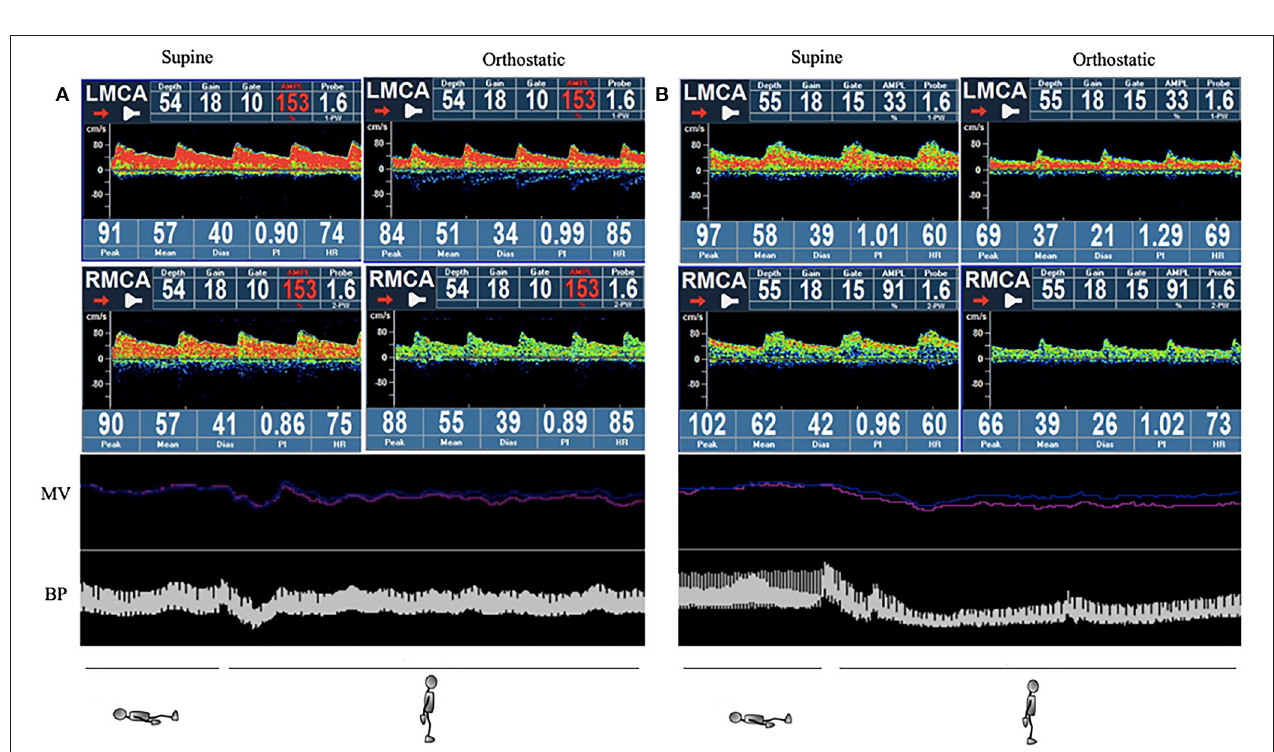
FIGURE 1 | Outcome of cerebral autoregulation. Column bars represent normalized gain during (A) supine position and (B) orthostatic position. Lower gain indicates more effective cerebral autoregulation. * p < 0.05.